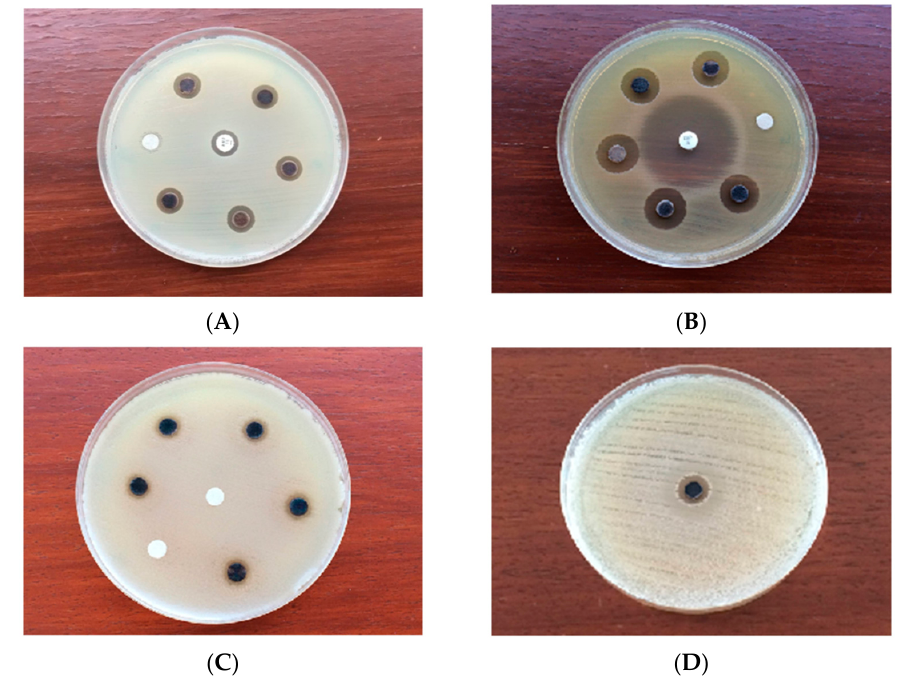
Figure 7. Antimicrobial activity of the synthesized AgNPs against ( A ) S. aureus subsp. aureus (ATCC 11632) ( B ) E. coli (ATCC 10536) ( C ) C. albicans (ATCC 10231) ( D ) MDR E. faecium (ATCC 700221).